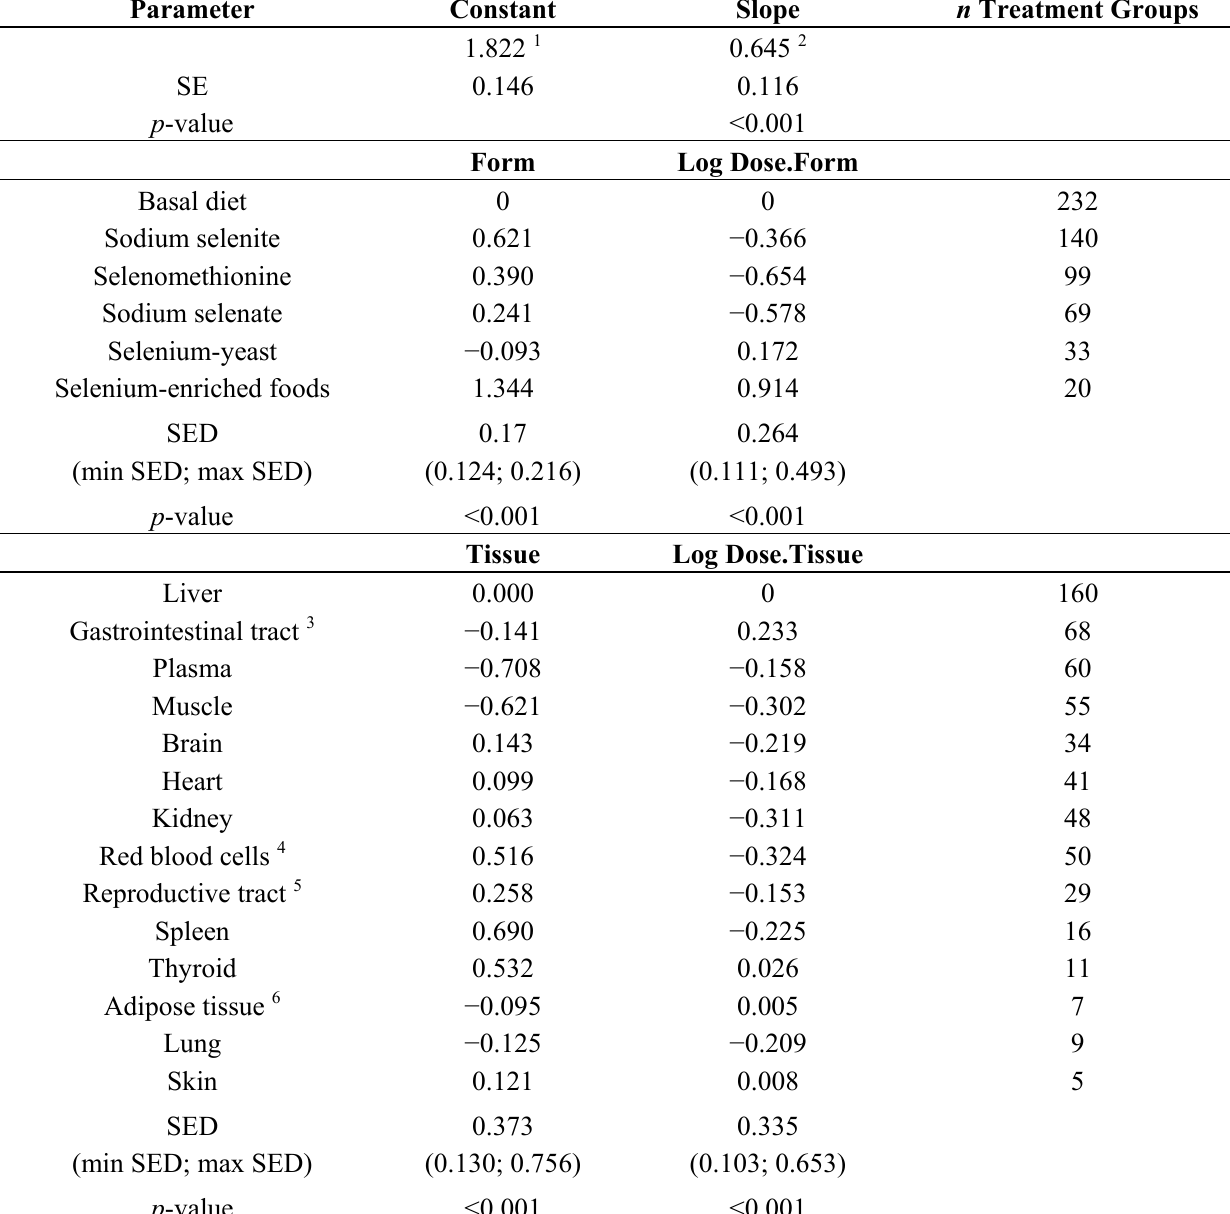
Table 3. Table of effects for the overall relationship between selenium supplementation and gluthathione peroxidase (GPx) activity for animal species. Dose response relationships were determined using the equation: Log GPx activity = [Constant + Form + Tissue + Animal] + [Log Dose.Form + Log Dose.Tissue + Log Dose.Animal]. Model coefficients or effects and the average standard error of difference (SED) between pairs of effects (with the minimum and maximum SEDs where appropriate) are